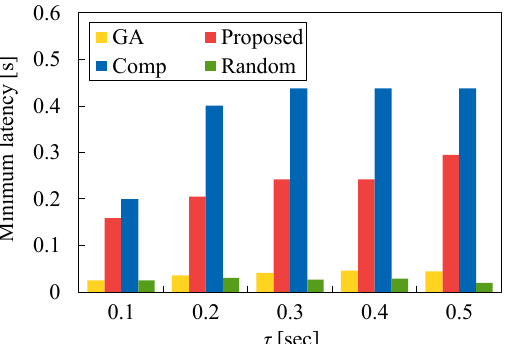
Figure 11. Minimum latency for each method versus τ in the case of N 1 = 50 and λ = 2.0.